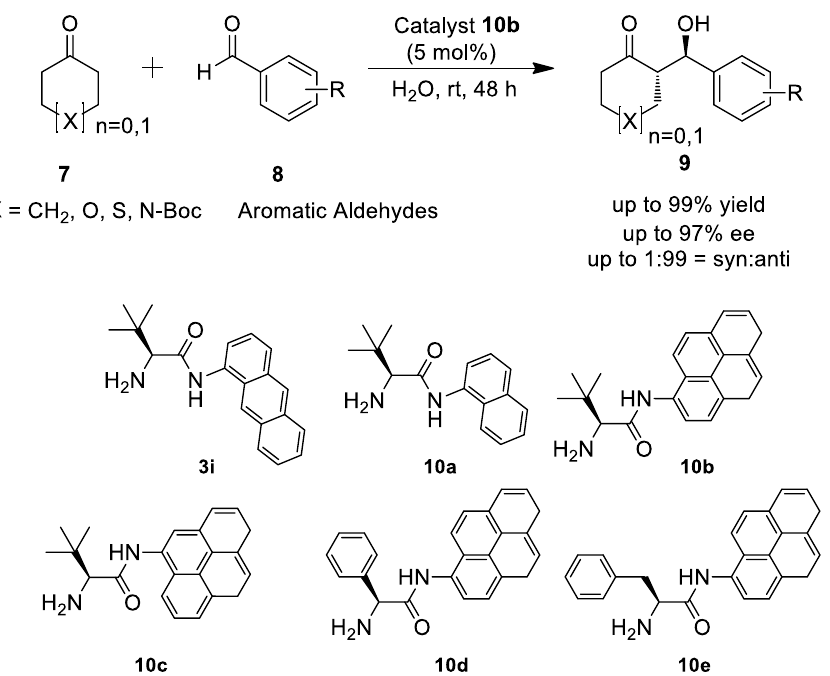
syn : anti 1:99, up to 97% ee ) with a low-loading catalyst (5 mol%) (Scheme 7) [70].